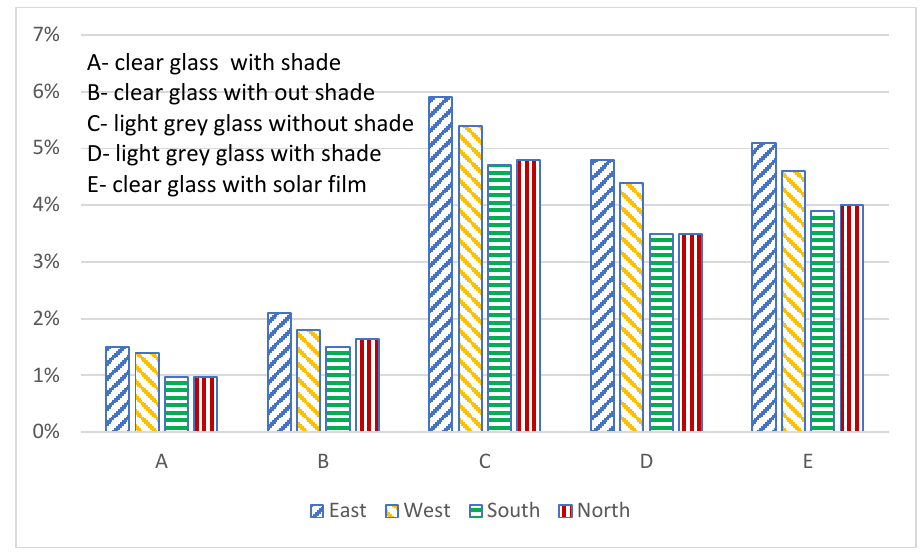
ff erent façades after retrofitting with low-e double Figure 7. Annual energy savings % for different façades after retrofitting with low-e double glazing. Figure 7. Annual energy savings % for di